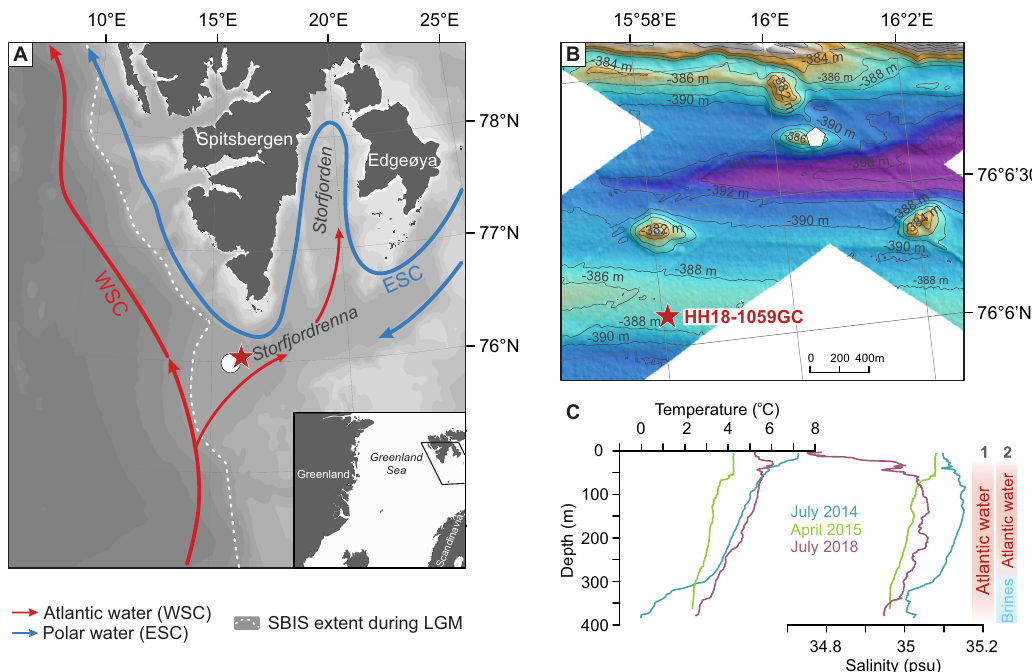
Fig. 1 Physical oceanography and bathymetry of the study area. A Map showing major surface currents (based on ref. 10 ) and maximum extent of Svalbard-Barents Sea Ice Sheet (SBIS) during the Late Glacial Maximum (LGM) according to ref. 9 (dashed white line). B Bathymetric map of the Pingo Area of methane hydrate mounds in the northwestern Barents Sea, where gas seepage occurs (Fig. S1). C Conductivity-Temperature-Depth (CTD) pro fi les (July 2014 and April 2015 from core site of JM02-460; July 2018 from core site of HH18-1059GC). The right columns in panel ( C ) indicate the two different hydrographic scenarios: 1 = when Atlantic Water occupies the entire water column and 2 = when a winter polynya and winter conditions allow the formation of brine enriched shelf waters. Star shows the location of core HH18-1059GC (1059 in text). Location of core JM02-460 15 is indicated with a white circle ( A ) and core CAGE 15-2 920GC (920 in text) 24 is shown with white pentagon ( B ). WSC: West Spitsbergen Current; ESC: East Spitsbergen